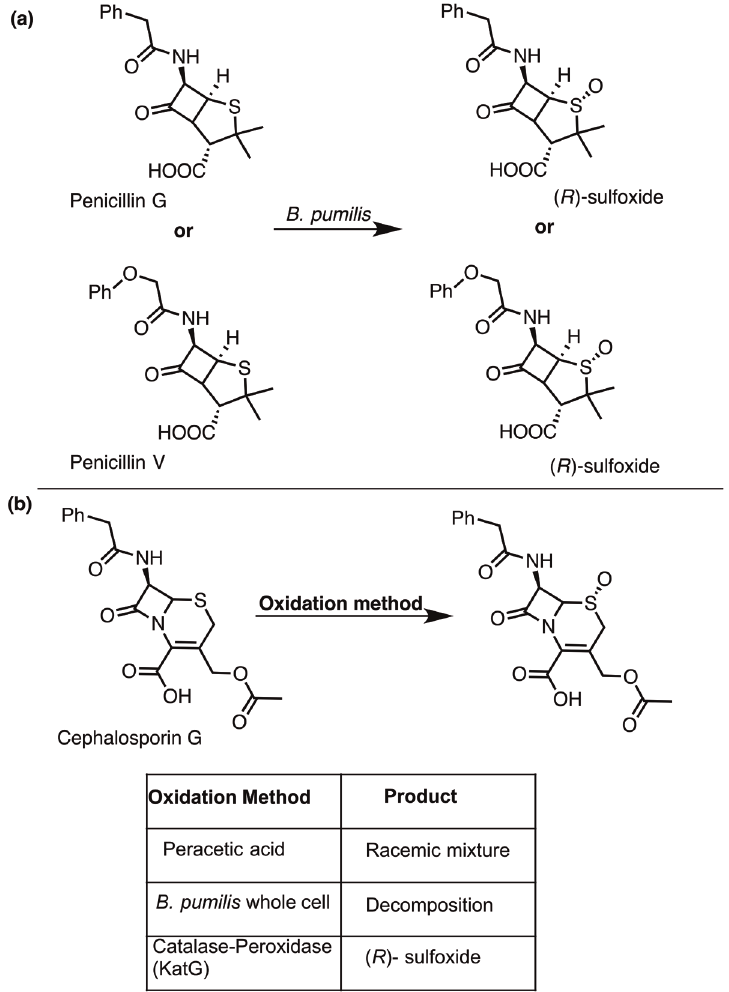
Figure 32 - Oxidation of Cephalosporin G, Penicillin G and Penicillin